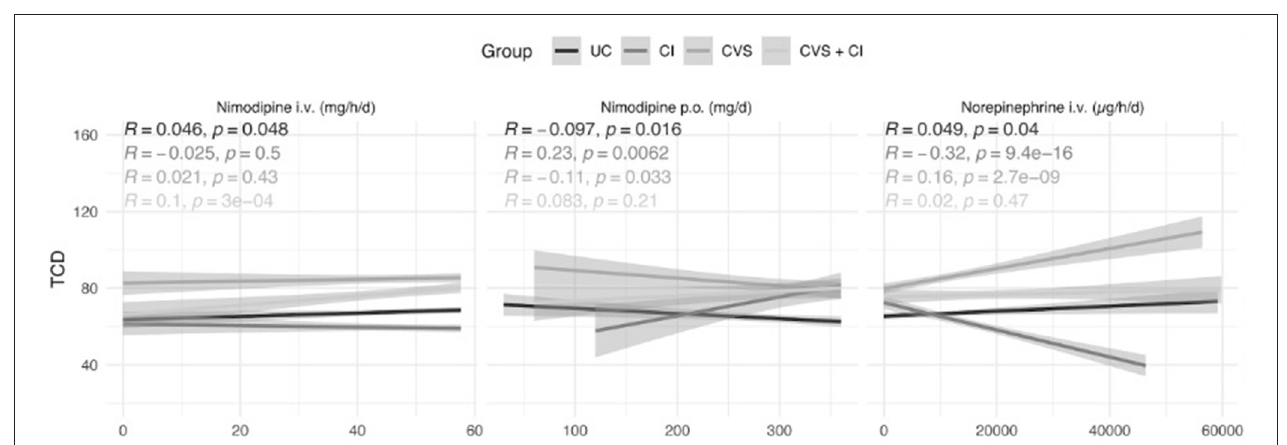
FIGURE 5 | Correlation of Transcranial Doppler Sonography to oral and i.v. nimodipine. Groups: Red line—uncomplicated; green line Infarcts, blue line vasospasms, and purple line vasospasms and infarcts. To unveil dosage effects correlation analysis were done. All TCD values are depicted and correlated to the Nimodipine iv., oral and Norepinephrine cumulative dosage over 24h. Linear regression line with the according standard error are depicted for the defined groups. Pearson correlation coefficient and the according p -value are shown in the upper left of the plots.